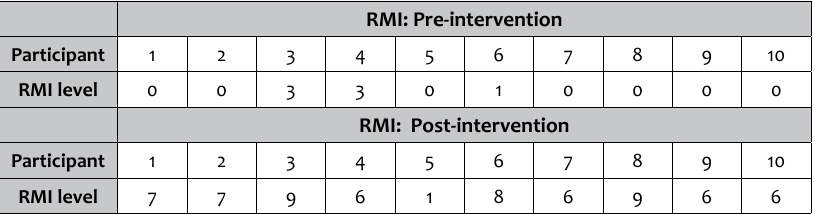
RMI: Pre-intervention